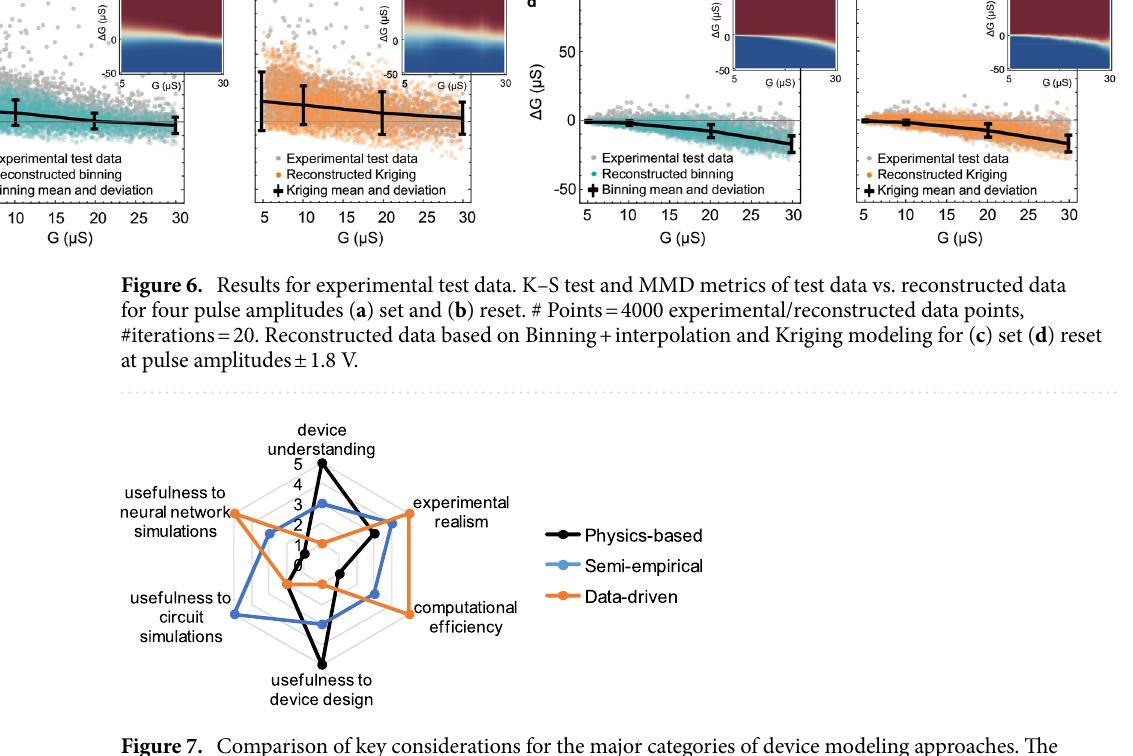
Figure 7. Comparison of key considerations for the major categories of device modeling approaches. The proposed two-tier Kriging approach can be classified as a data-driven device modeling